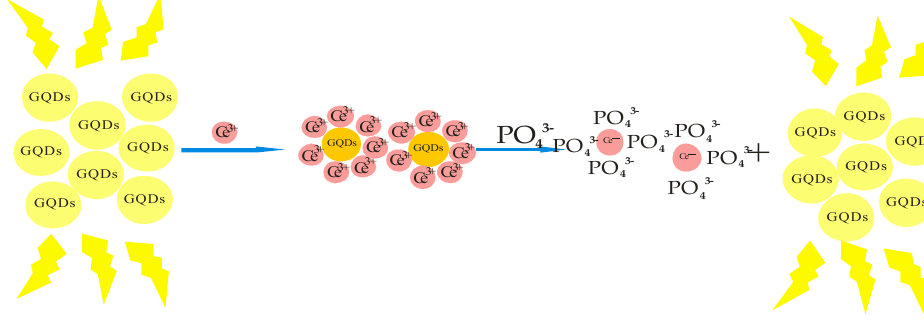
Figure 14. Design of phosphate sensors based on GQDs/Ce 3+ nanoparticles.